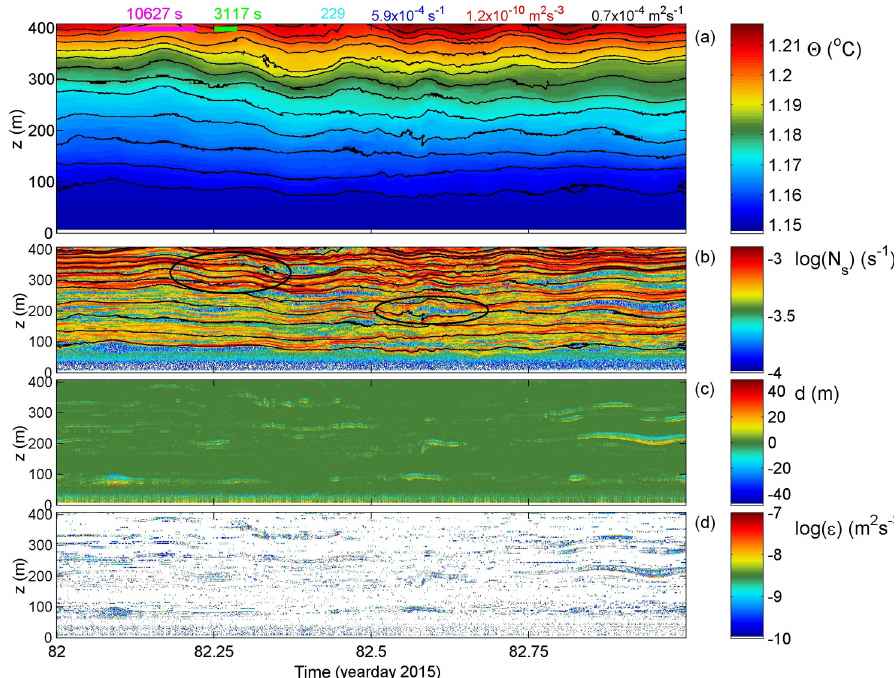
Figure 3. A 1-day sample detail of moored temperature observations during relatively calm conditions (on the day of calibration in the beginning of the record). (a) Conservative temperature. The black contour lines are drawn every 0.005 ◦ C. At the top from left to right are two time references indicating the mean (purple bar) and shortest (green bar) buoyancy periods found in this data detail. Values for time– depth–range–mean parameters are given by the buoyancy Reynolds number (light blue), buoyancy frequency (blue), turbulence dissipation rate (red) and turbulent eddy diffusivity (black). Errors for the latter two are to approximately within a factor of 2. (b) Logarithm of small- scale (2dbar) buoyancy frequency from reordered temperature profiles. The black isotherms are reproduced from panel (a) . (c) Thorpe displacements between raw (a) and reordered T profiles. (d) Logarithm of turbulence dissipation